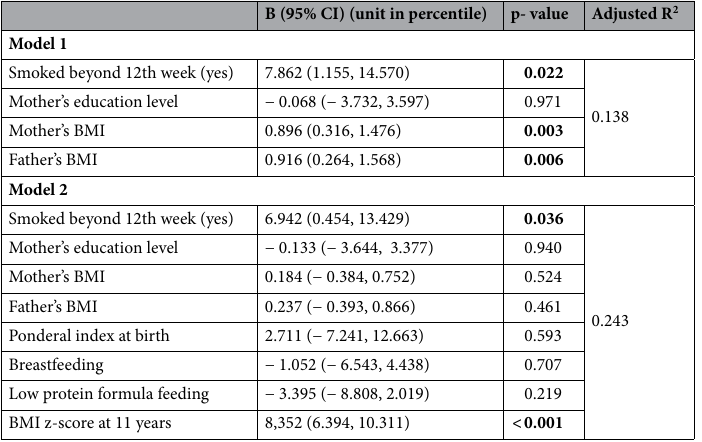
Table 3. Lineal regression models assessing the effect of maternal smoking beyond 12th week of gestation on SBP percentile at 11 years. Sample size 542 patients because of missing data. Model 1 adjusted by country and sex. Model 2 adjusted by country, sex, and other post-exposure potential confounders such as child’s anthropometry or feeding (comparison group for feeding high protein). Significant values are in